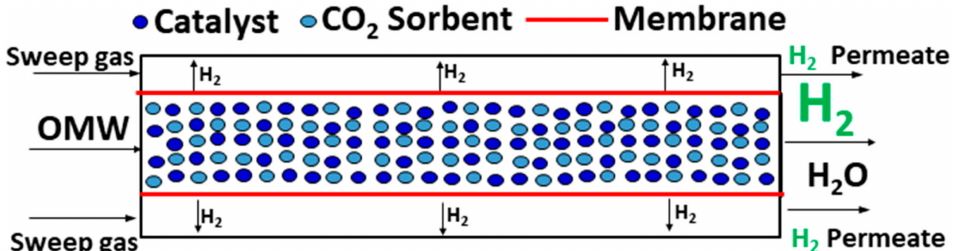
Figure 19. Scheme of the operation of the